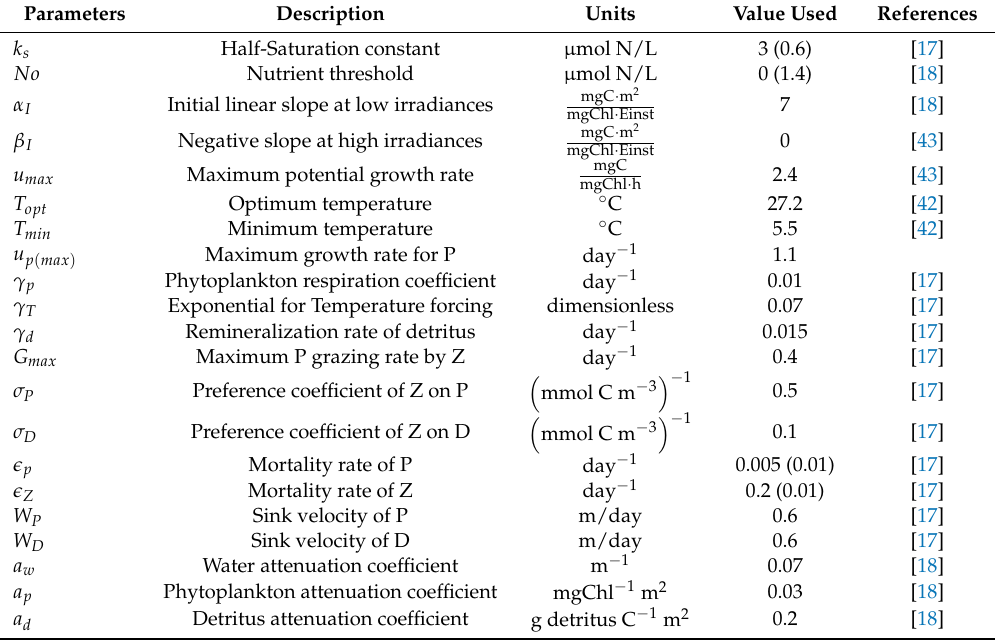
Table A1. Biological model formulation and parameters; the original value of the parameters is provided in ( ) if tuned value was